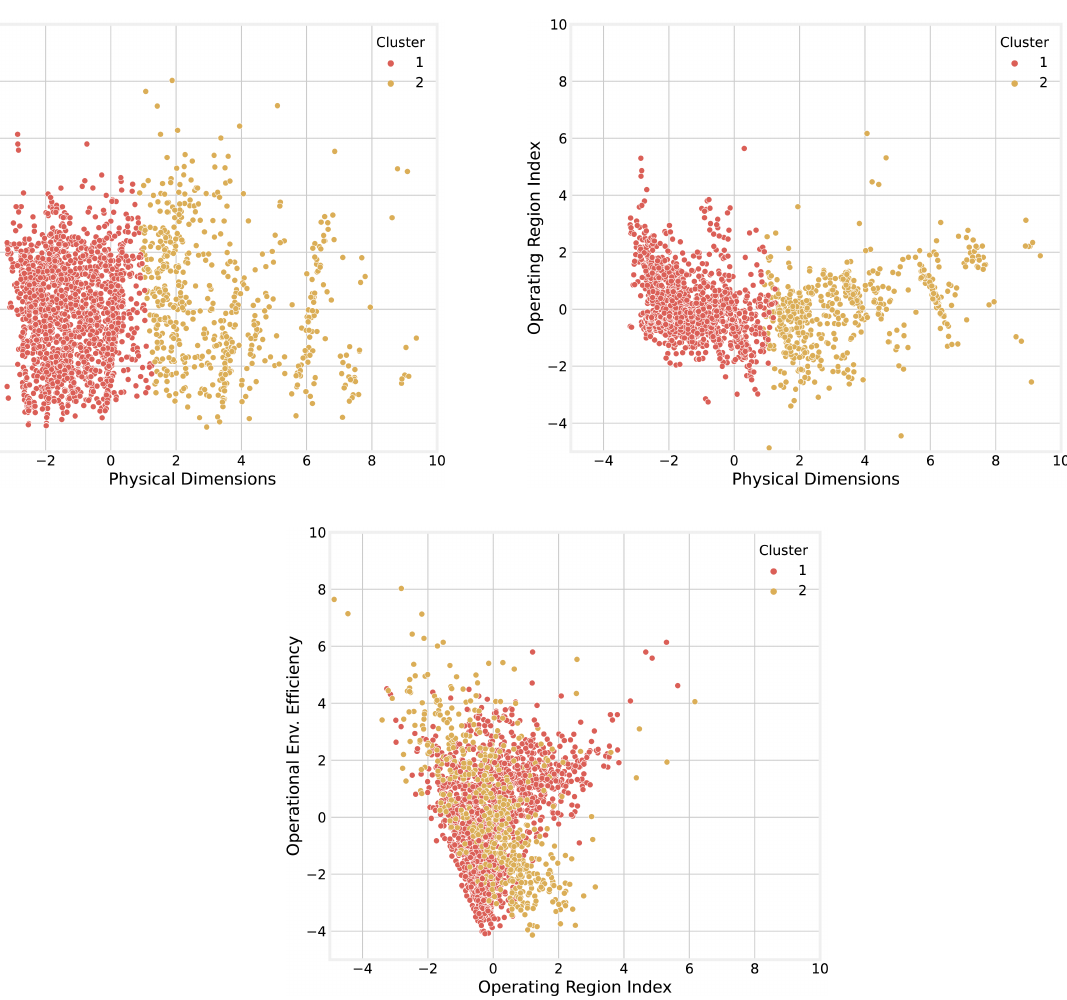
Figure 10. The two clusters (colored with red and brown) defined by the k-means algorithm plotted with respect to the PCs. Upper left plot: clusters on the plane defined by first and second PCs. Upper right plot: clusters on the plane defined by first and third PCs. Lower plot: clusters on the plane defined by second and third